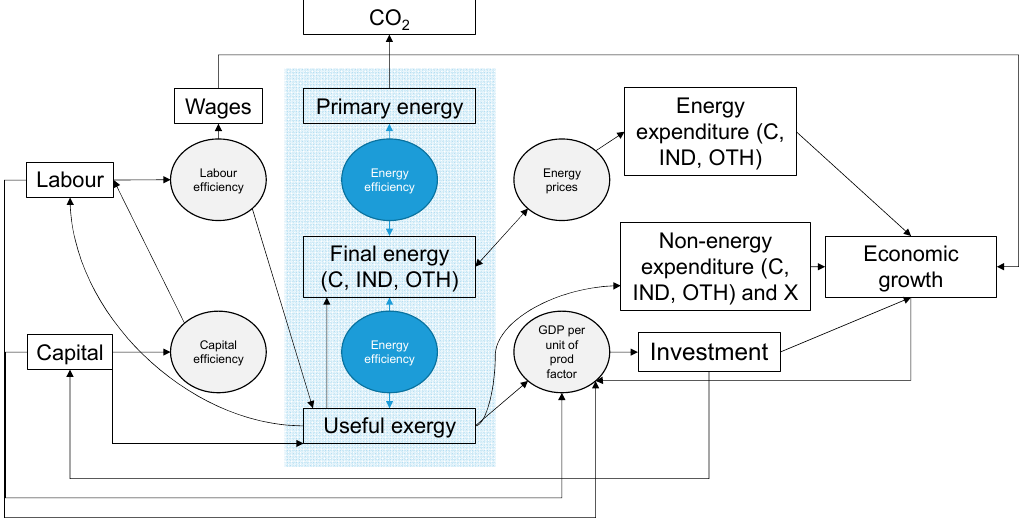
Figure 2 . Schematic MARCO-UK model structure. Figure 2. Schematic MARCO-UK model